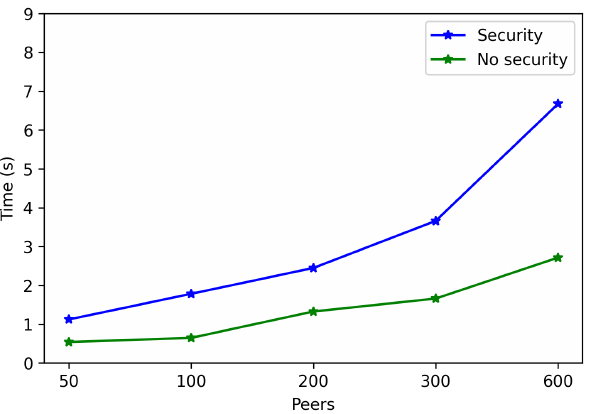
Figure 27. Mean latency when enabling/disabling TLS